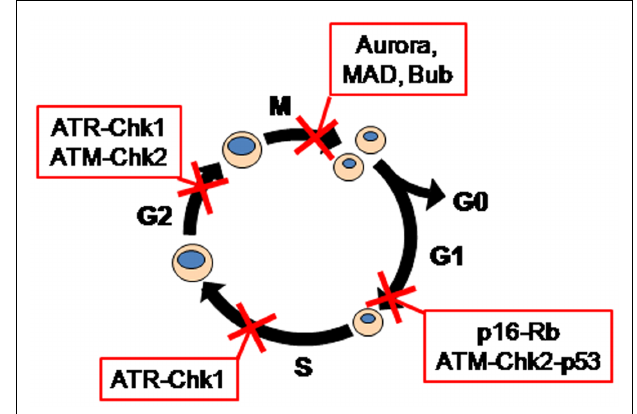
FIGURE 2 | Checkpoint regulators.